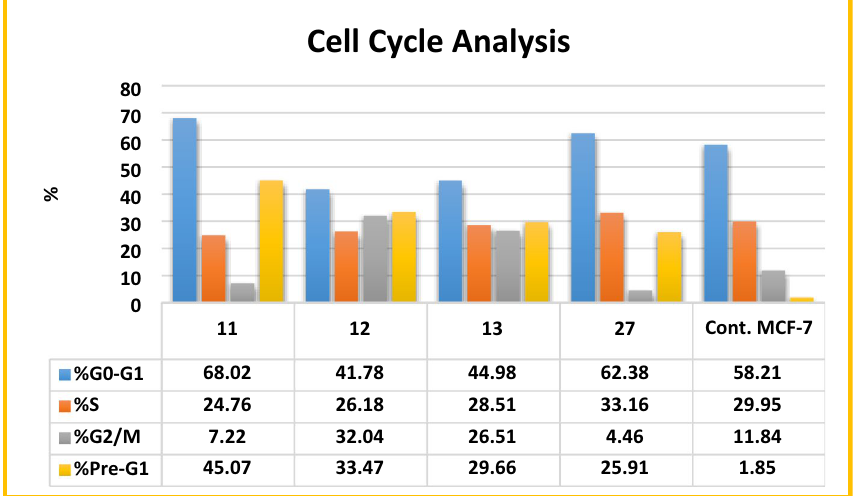
Figure 7. Cell cycle phase distribution in MCF-7 cell line treated with vehicle control and the newly synthesised compounds; 11 , 12 , 13 and 27